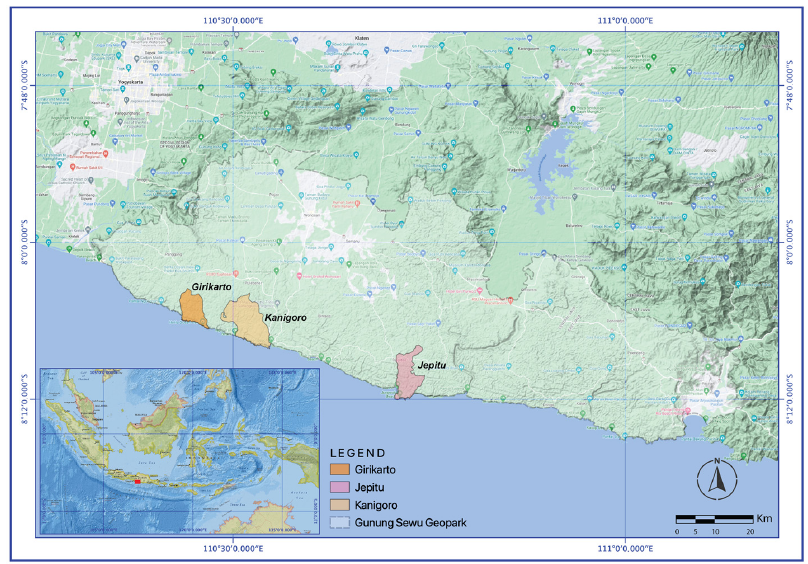
Figure 2. Orientation Map of Girikarto, Kanigoro and Djepitoe Village in Gunungsewu Geopark. Source: Researchers’ analysis created using QGIS 3.4.